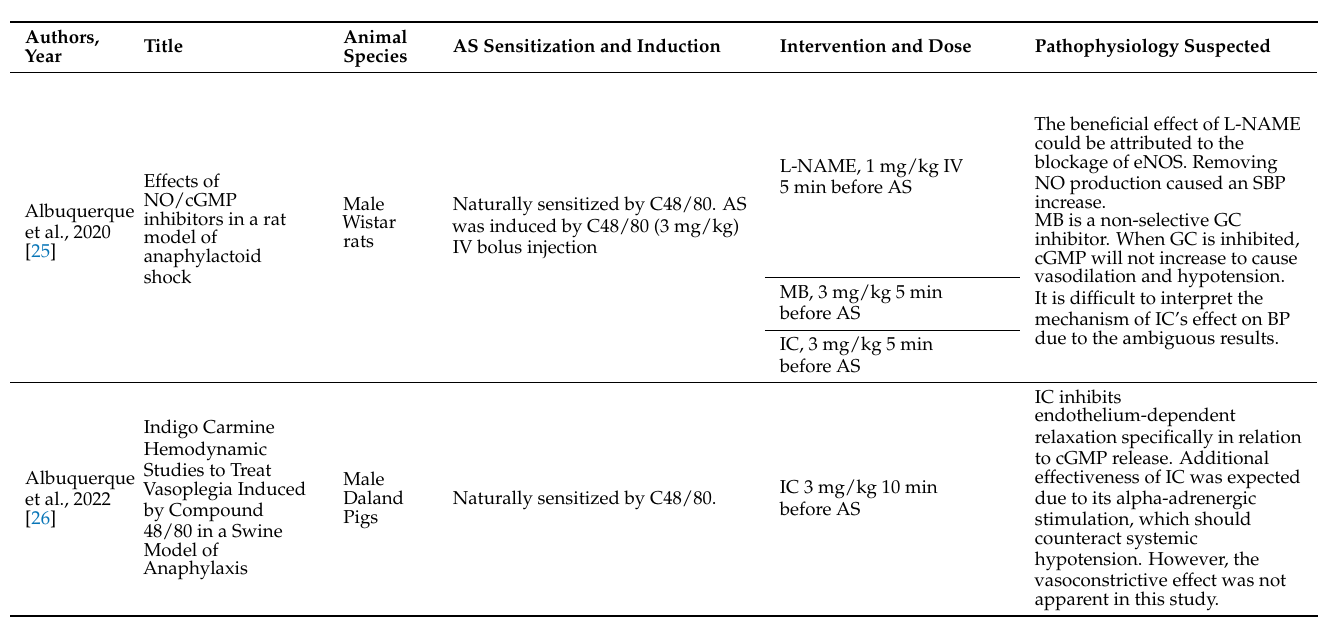
Table 2. Post-treatment study characteristics. Anaphylactic shock (AS), bovine serum albumin